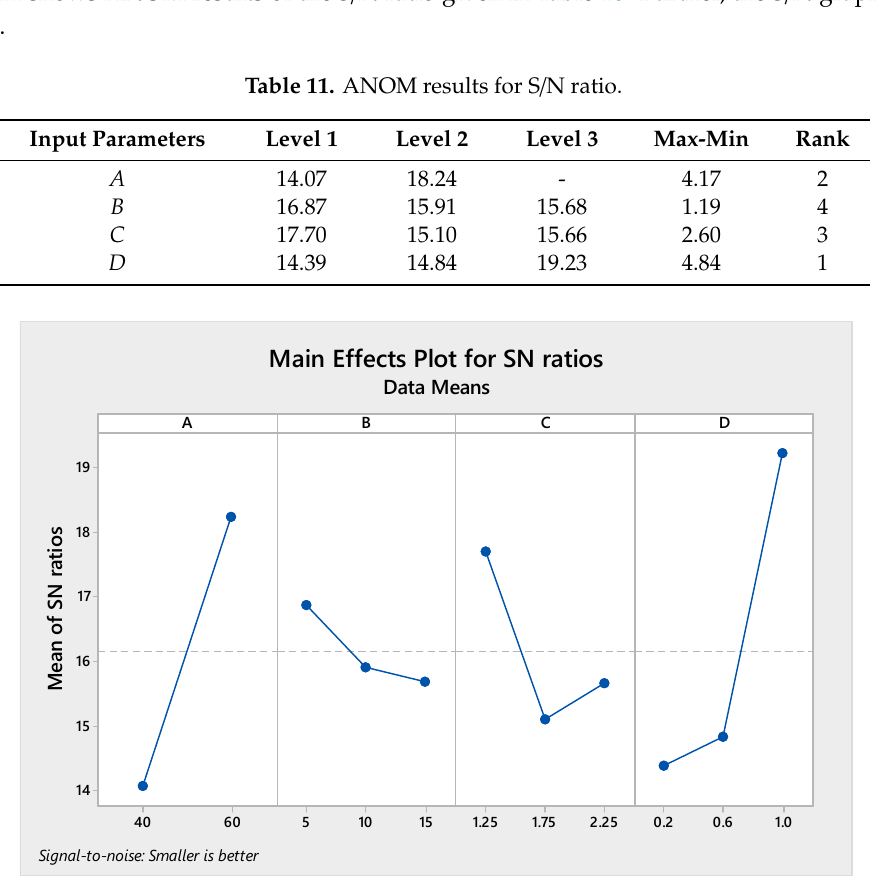
Table 10. Overall proximity index value and corresponding S/N ratio.